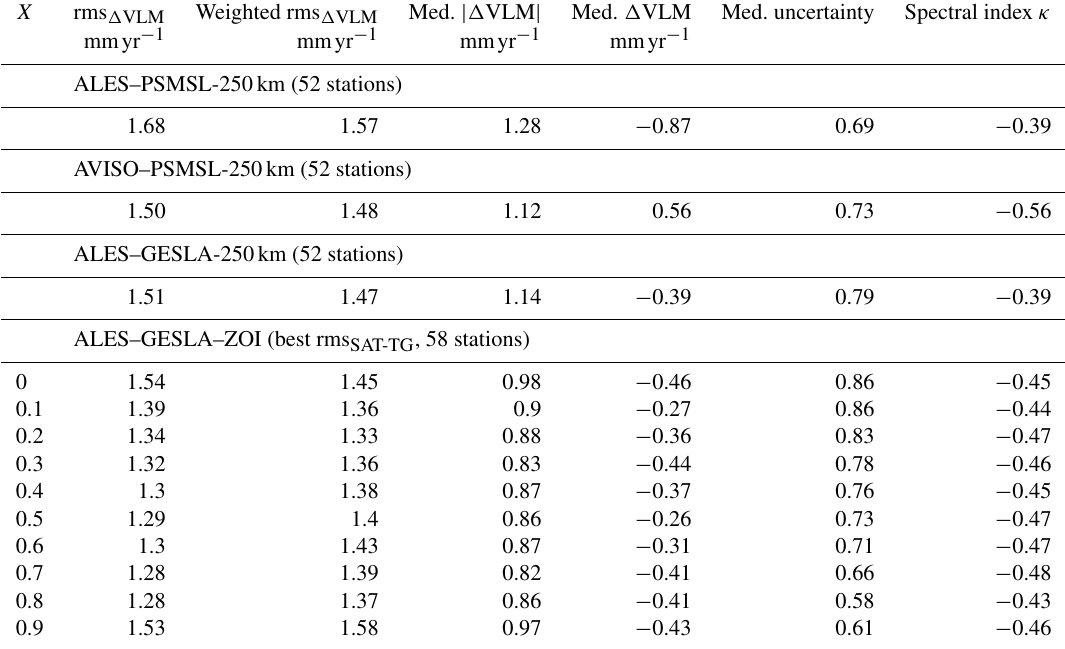
Table 2. Statistics of different SAT–TG combinations. (cid:49) VLM refers to the differences of VLM SAT-TG and VLM GNSS trends. X denotes the relative level of comparability above which data are included. X rms (cid:49) VLM Weighted rms (cid:49)